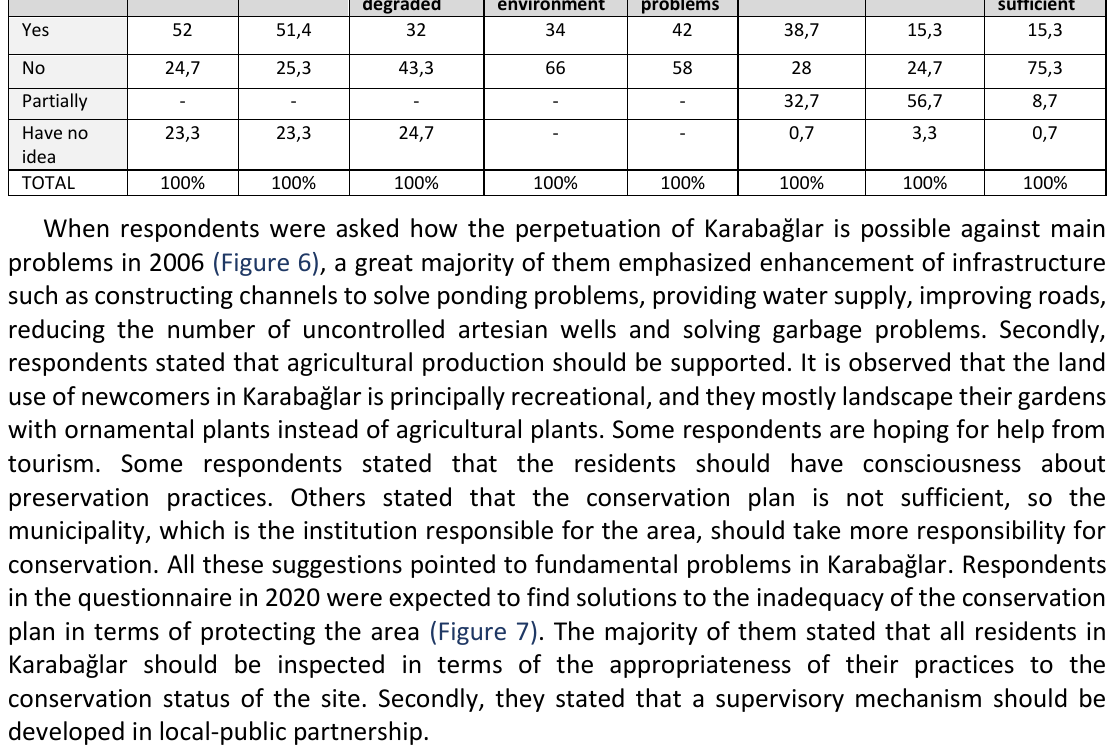
Table 6 Answers to the question: What does the perpetuation of Karabağlar depe nd on? OUESTION Percent (%)